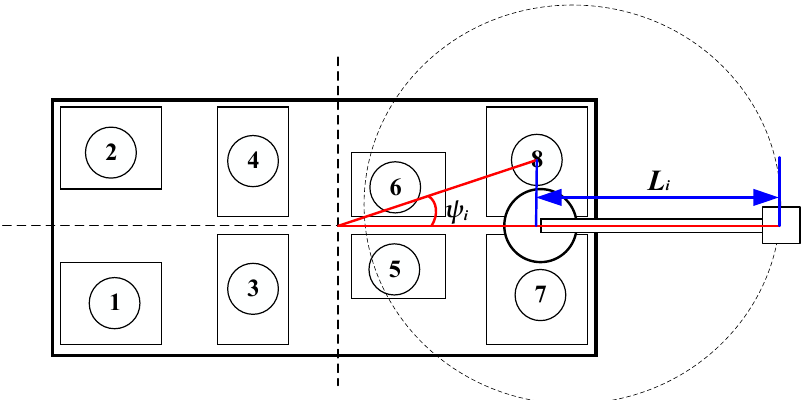
Figure 6. Schematic diagram of the reasoning decision variables under a certain working condition. ψ i is the angle between the lifting cargo and the ballast tanks; L i is the distance between lifting cargo and the ballast tanks.